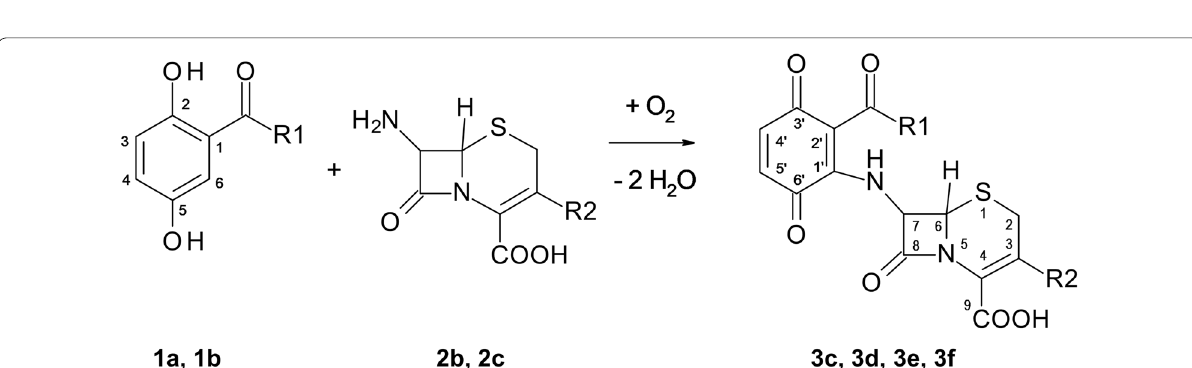
Fig. 3 2,5-Dihydroxybenzoic acid derivatives ( 1a R1 7-aminodesacetoxy-cephalosporanic acid ( 2c R2 R2 CH 2 OCOCH 3 ), 3e (R1 =